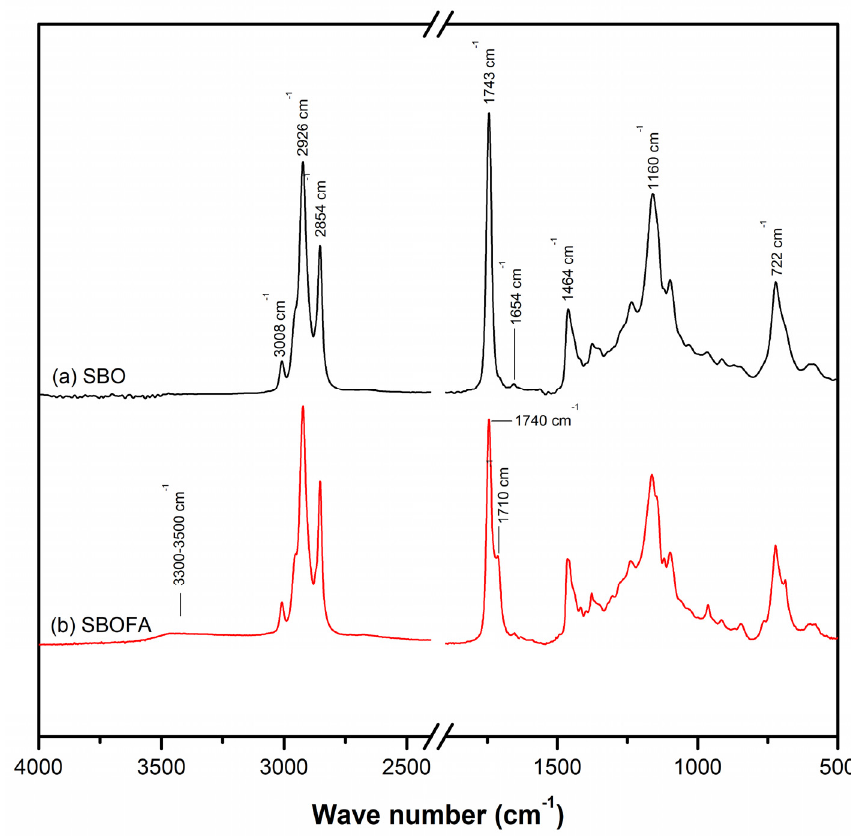
Figure 1. Representative ATR-FTIR spectra of the ( a ) SBO and ( b ) SBOFA.